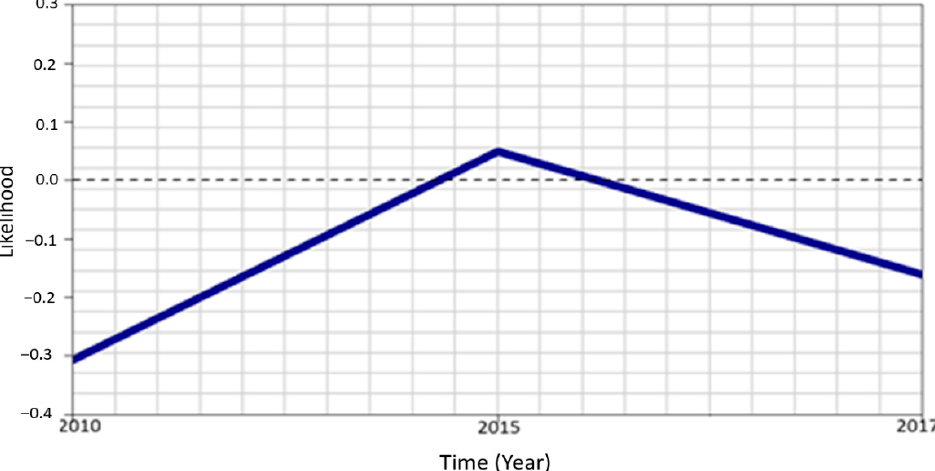
Figure 9. The trend of FGM/C over time. Evidence from the fully adjusted model fitted to com- bined data (Model